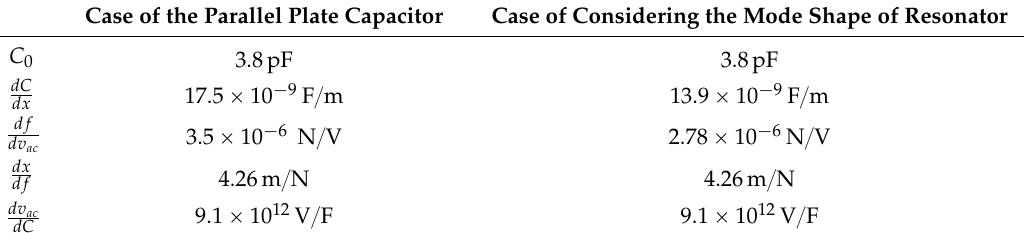
Table 3. The electromechanical